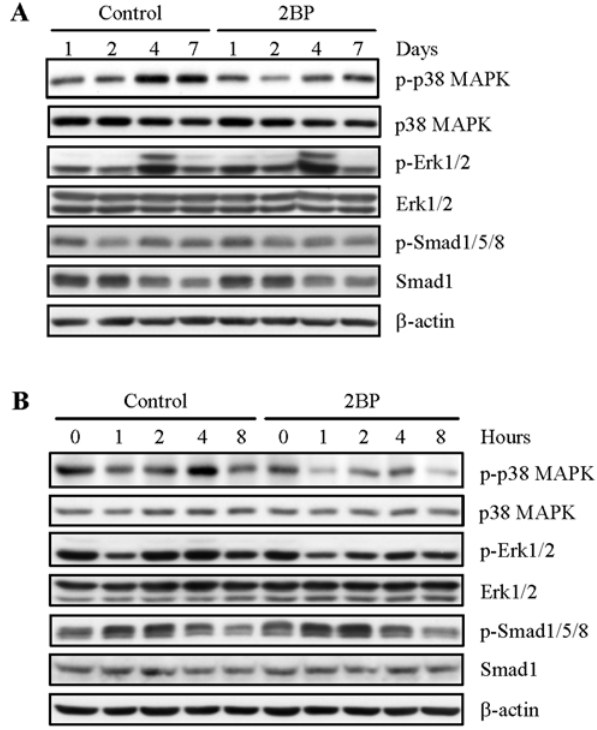
Figure 7. Inhibition of protein palmitoylation compromised p38 MAPK. A. 2BP showed an inhibitory effect on p38 MAPK activation in differentiation assays, without a significant effect on Erk1/2 activation or Smad1/5/8 activation. Primary osteoblasts were cultured in differentiation medium with or without 2BP for different periods of time. Cells were collected for Western blot analysis of the activation of p38, Erk1/2, and Smad1/5/8. B. 2BP also compromised p38 MAPK activation in response to BMP2. Primary osteoblasts were pretreated with PAT inhibitor overnight, and then stimulated with 100 ng/ml of BMP2. Cells were collected at different time points for analysis of p38 and Erk1/2 activation.